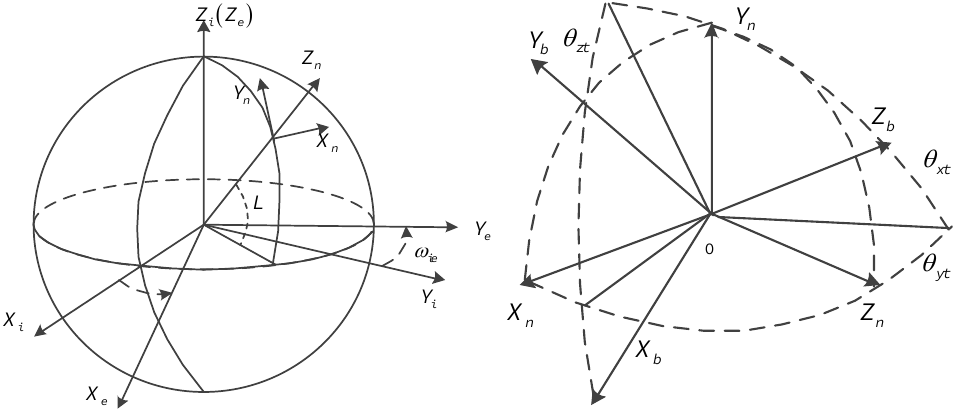
Figure 2. The coordinate frames used in this paper.